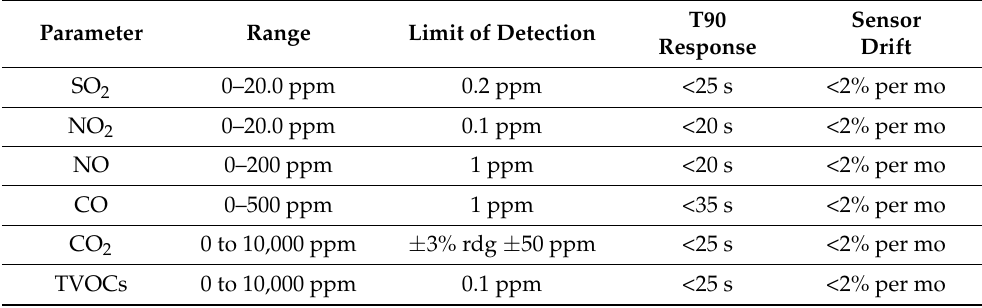
Table 2. Measurement specifications of the Gray Wolf’s DirectSense Gas